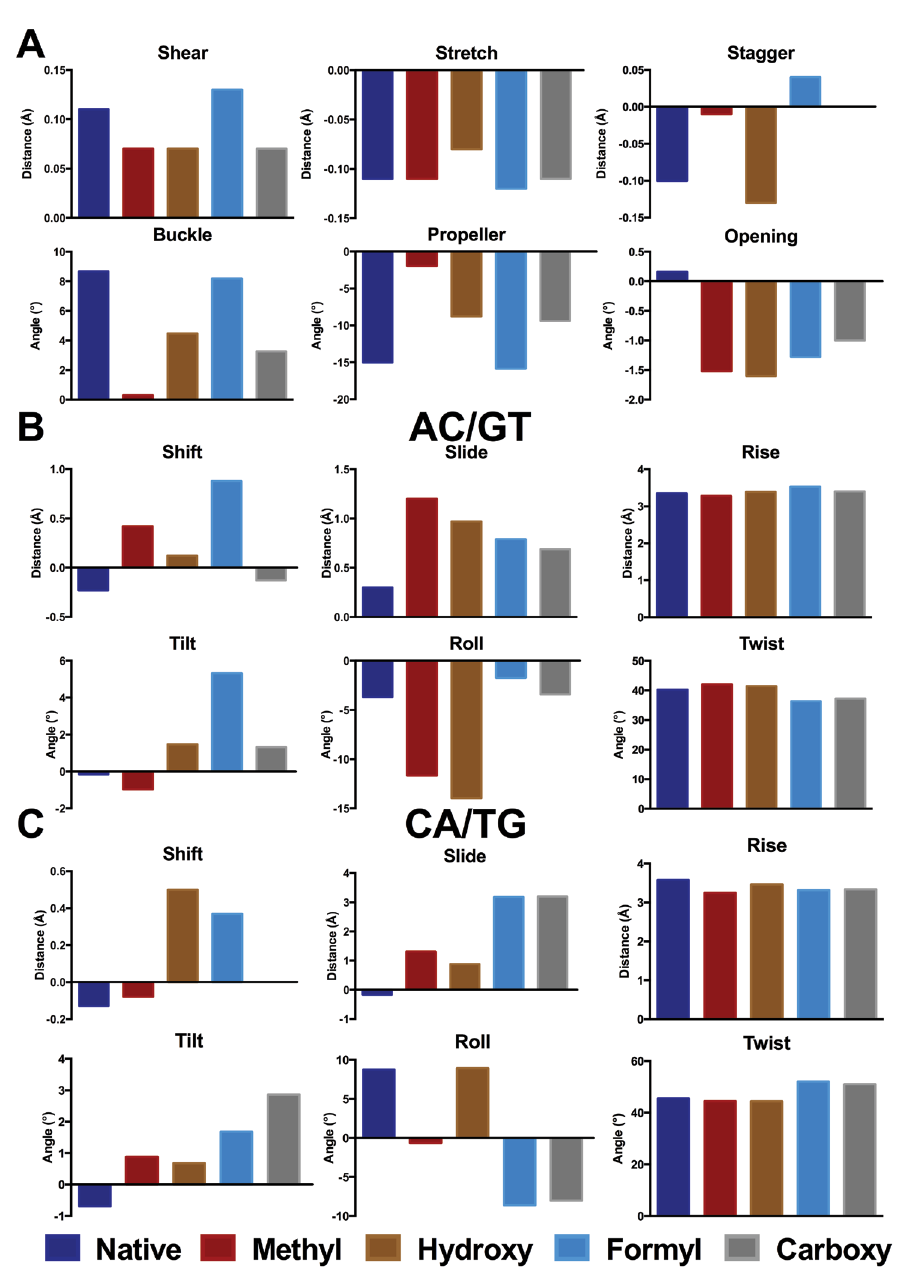
Figure 3. Base pair (A) and step (B, C) parameters for central GC and modifications thereof in d(ACA) (Å and °). The corresponding data are provided in Data file